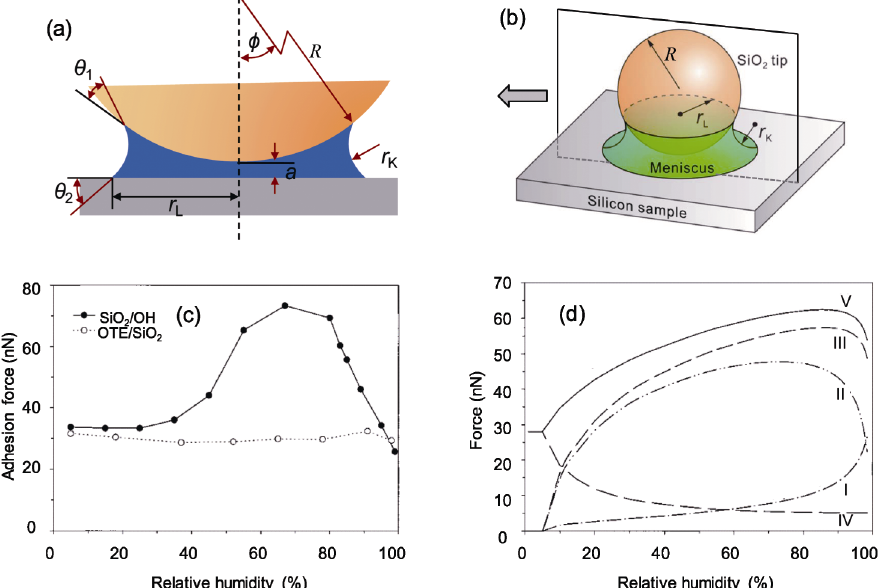
Fig. 5 (a, b) Geometry of meniscus condensed on single-asperity contact interface; R is sphere radius; (cid:31) is filling angle; r K is Kelvin radius of meniscus; r L is meniscus radius; a is minimum separation at sphere–plane interface; θ 1 and θ 2 are contact angles of sphere and substrate, respectively; (c) adhesion forces as function of RH on relatively hydrophilic SiO 2 surface and hydrophobic OTE/SiO 2 surface obtained in AFM tests; (d) theoretical calculation results on contributions to adhesion force from (I) surface tension force, (II) capillary pressure force, (III) total capillary force, (IV) van der Waals force, and (V) adhesion force. Reproduced with permission from Ref. [74], © American Chemical Society